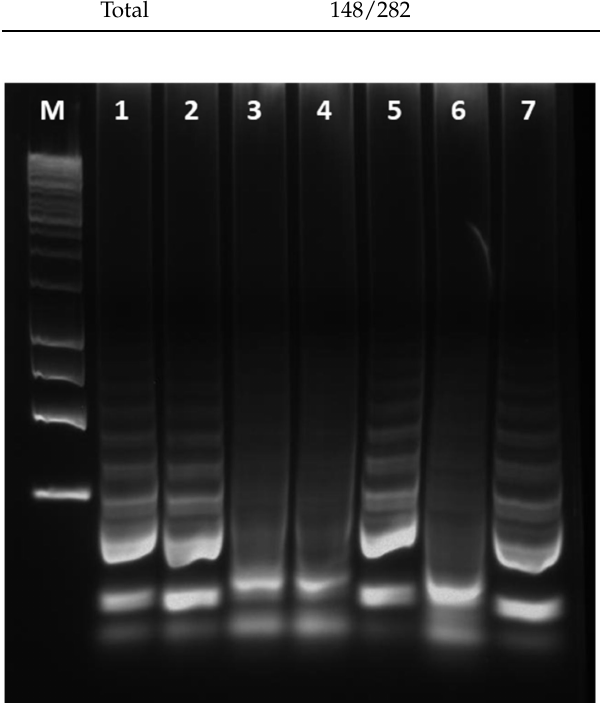
Figure 4. Electrophoresis of the cLAMP products from field-olive samples. 1–2: samples positive amplification in samples which produce no amplification in qPCR but a colour change in cLAMP; 6: sample testing negative in qPCR with a yellow-colour change in cLAMP; M: DNA size